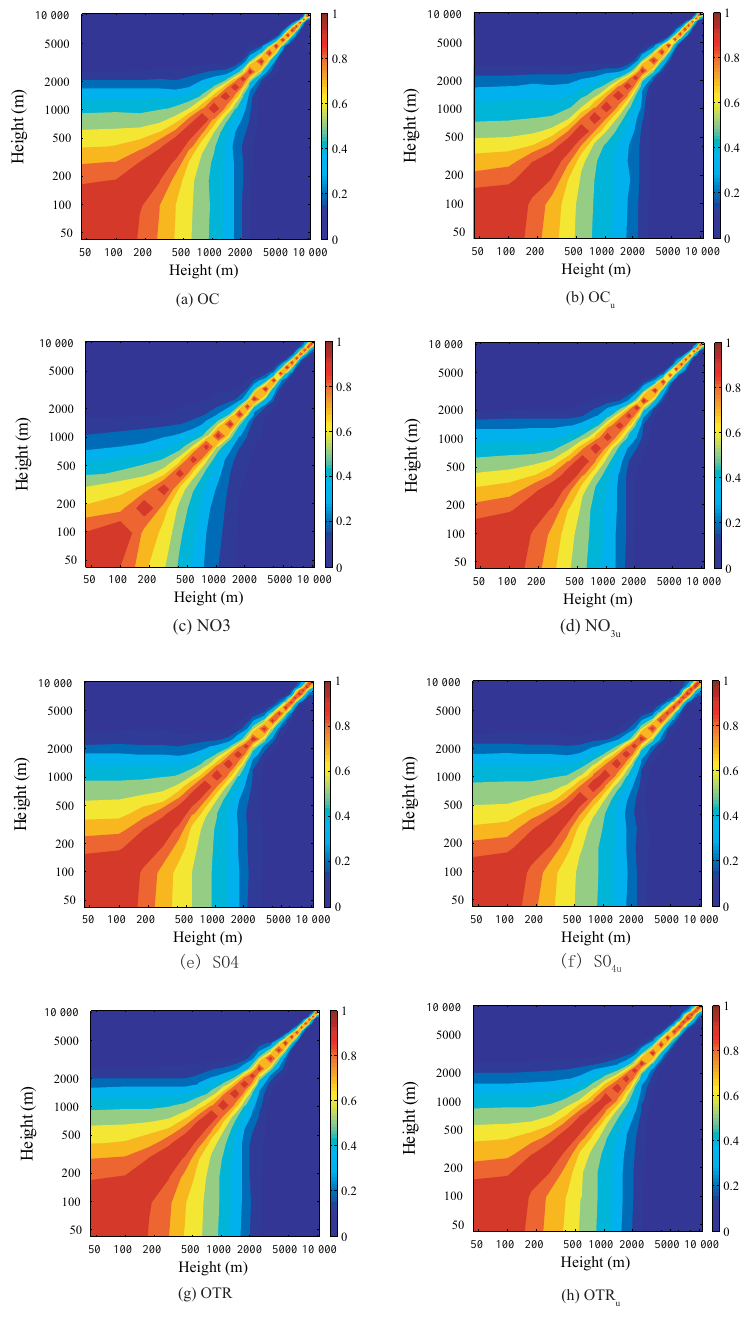
Figure 6. Vertical correlations of the five variables of the BEC. The left column represents the full variables, and the right column represents the unbalanced